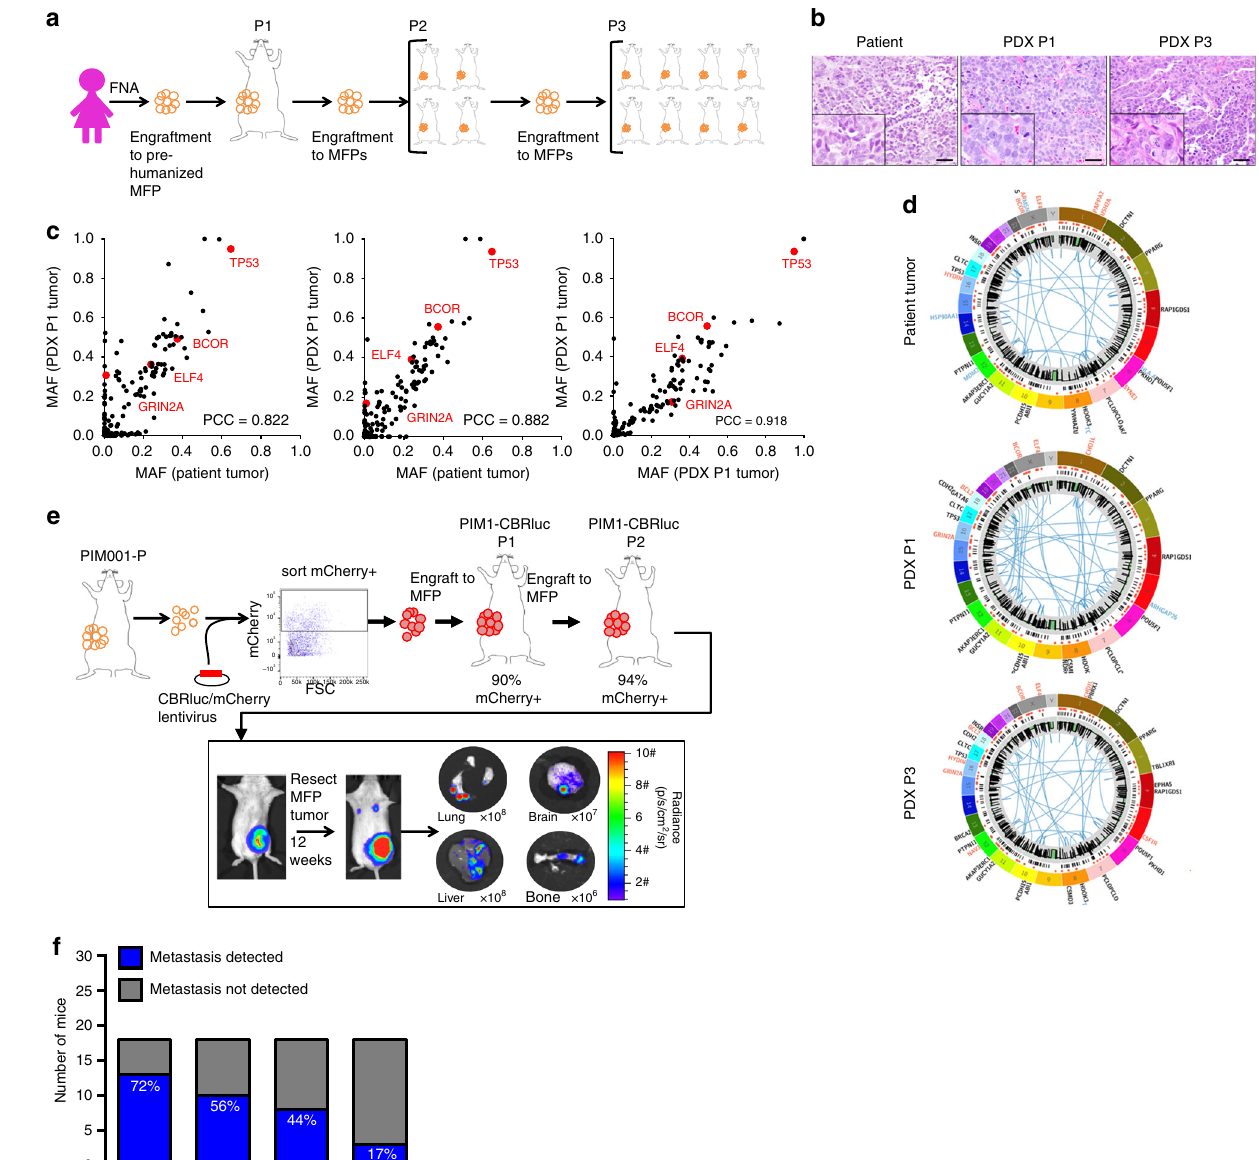
Fig. 1 Generation of a genomically heterogeneous PDX model of TNBC. a Establishment of the PDX model PIM001-P. FNA, fi ne-needle aspirate biopsy. MFP, mammary fat pad. b Pictomicrographs of H&E-stained sections of the patient ’ s tumor and PDX tumors are shown. Images are 10×, and insets are 40× magni fi cation. Scale bars represent 100 μ m. c The mutant allele frequencies (MAFs) of mutations detected by WES and validated by targeted sequencing were compared with each other and with MAFs of the patient ’ s tumor. Mutations in COSMIC cancer genes are shown in red. Pearson Correlation Coef fi cients (PCC) are shown in the bottom right corner of each plot. d Circos plots were generated to visualize genomic structural rearrangements in patient and PDX tumors. Chromosomes are demarcated by distinct colors. e PIM001-P tumor cells were engineered to express click beetle red luciferase (CBRLuc) and mCherry. Following lentiviral transduction, mCherry-positive tumor cells were sorted by FACS and engrafted into the MFP of a NOD/SCID mouse. Tumors were isolated and re-passaged into recipient mice and mCherry positivity was con fi rmed at each passage by fl ow cytometry. BLI identi fi ed lung, liver, brain, and bone metastases in engrafted mice. In most cases, MFP tumors regrew in the primary site following surgical resection. f Percentage of engrafted mice with metastases in indicated organs ( n = was determined by quantitative PCR (Supplementary Figure 2a). RNA-seq data were computationally puri fi ed of mouse The six metastatic lesions with the highest human representation sequences. Top pathways signi fi cantly altered in PIM1-CBRLuc and corresponding MFP tumors from three mice were selected lung metastases relative to MFP tumors included cell – cell for RNA sequencing (RNA-seq), WES (mean target coverage adhesion, proteolysis, and blood vessel morphogenesis (Fig. 2b 209×), and targeted deep sequencing (mean target coverage and Supplementary Data 5). These pathways have well- 1636×; Fig. 2a). MAFs of mutations validated by targeted established roles in human metastasis 37 – 39 . Importantly, WES and targeted sequencing revealed most mutations were main- sequencing were highly concordant with those calculated from tained at similar frequencies in PIM1-CBRLuc MFP tumors WES, with 92% of all MAFs exhibiting <10% variance (Supple- compared to the patient ’ s primary tumor biopsy, the P1 parental mentary Figure 2b).